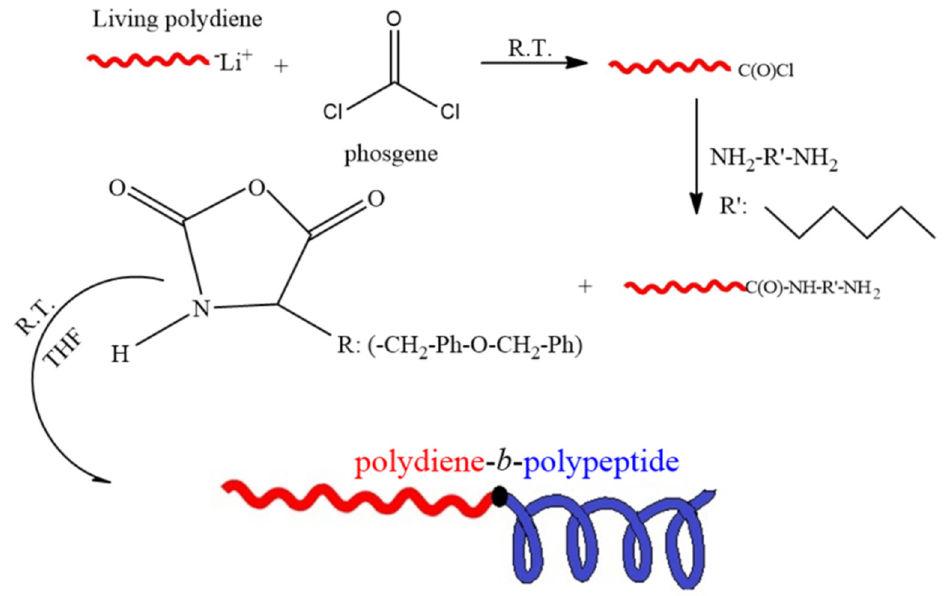
Figure 1. Schematic representation of the synthesis of the biobased hybrid materials.